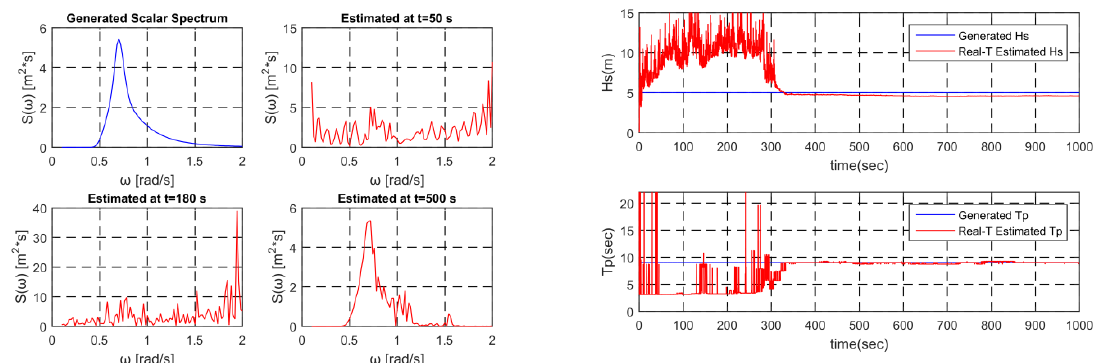
Figure 23. Generated and estimated spectrum/Evolution of parameters (Sea sate 2, Hs = 5 m, Tp = 9 s).